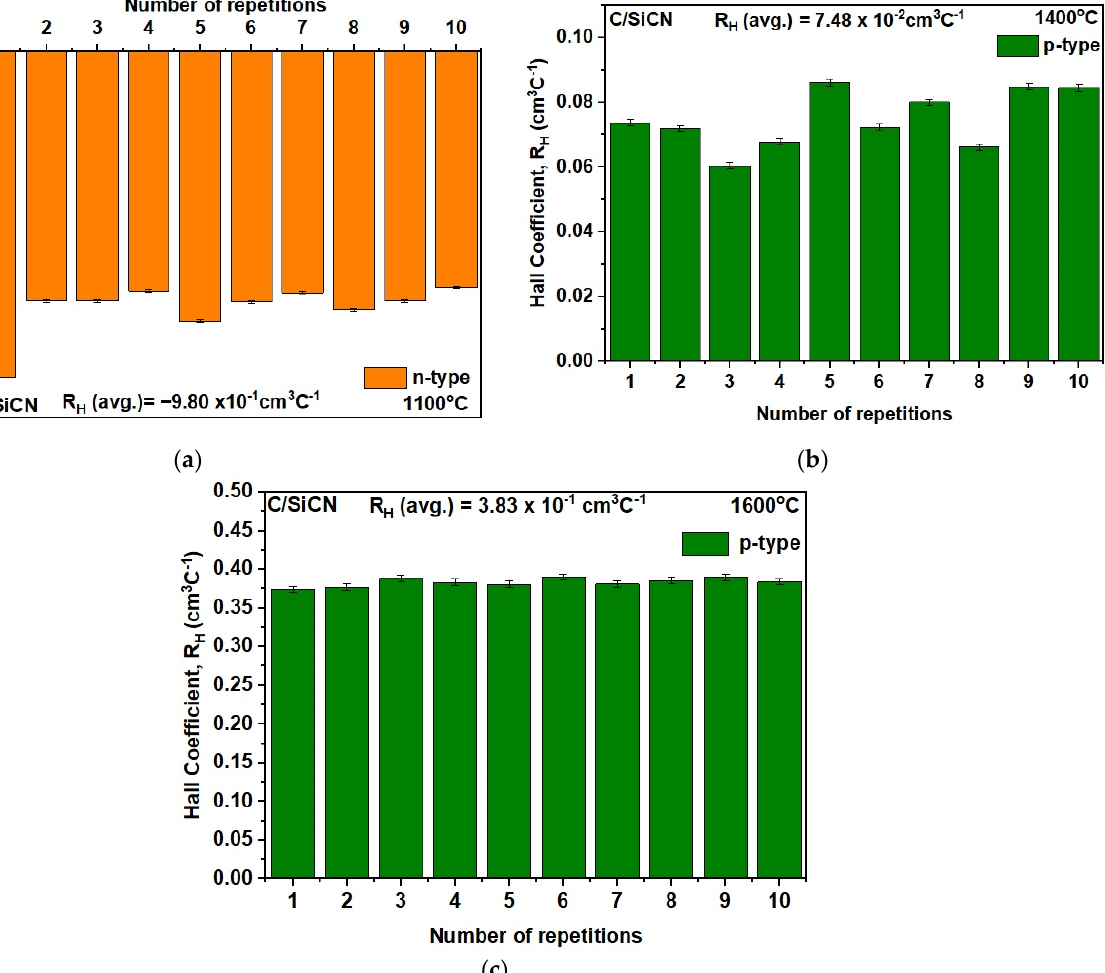
Figure 5. Hall measurement performed in 10 repetitions on the C/SiCN nanocomposites showing the shift in predominant charge carriers from n-type at 1100 °C to p-type at higher temperatures ≥ 1400 °C: ( a ) Hall coefficients at 1100 °C showing n-type carriers; ( b ) Hall coefficients of the